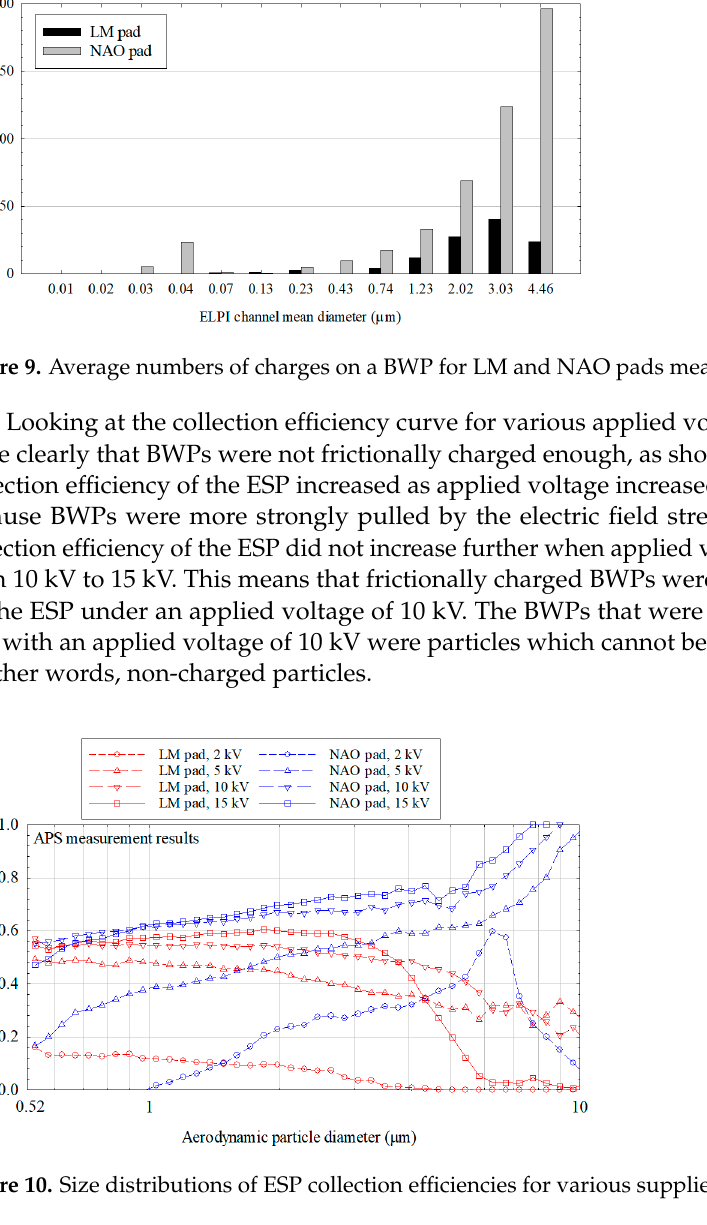
Figure 9. Average numbers of charges on a BWP for LM and NAO pads measured by the ELPI. When using the LM pad, collection efficiency decreased as BWP size increased above